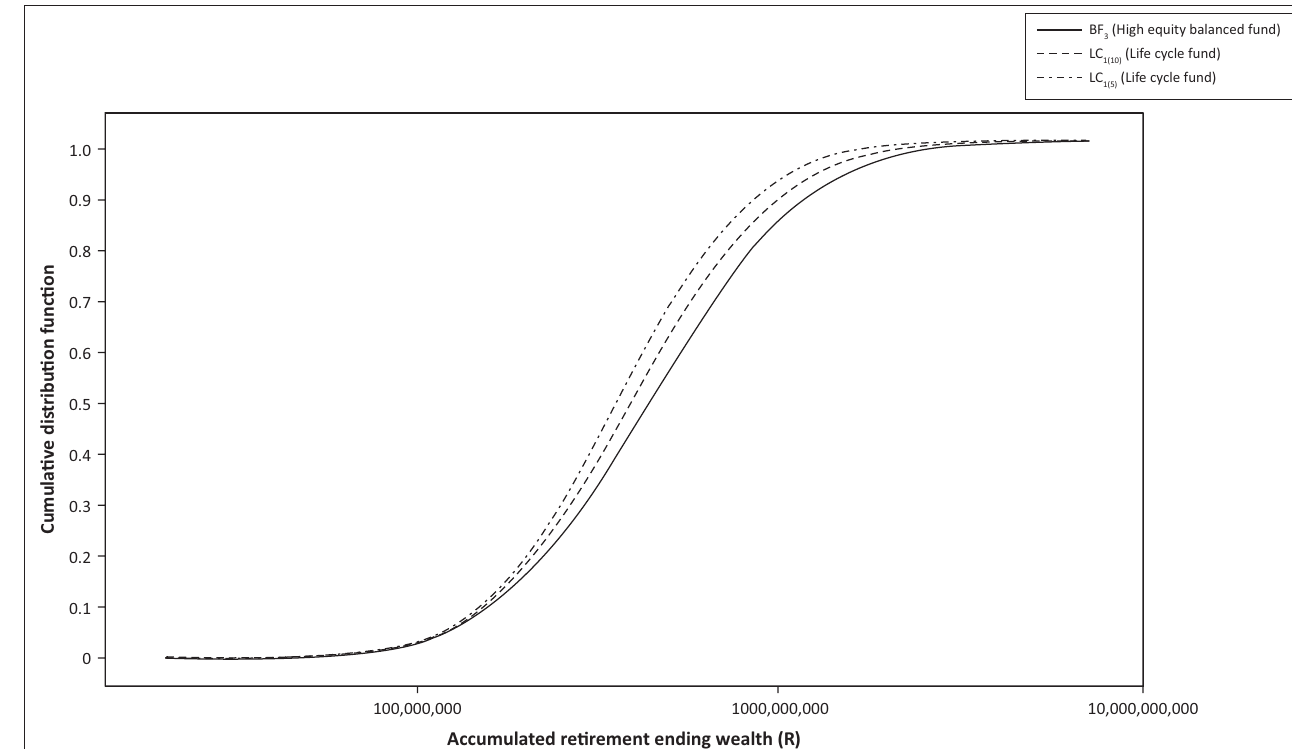
and LC against model BF . 1(10) 1(5) 3